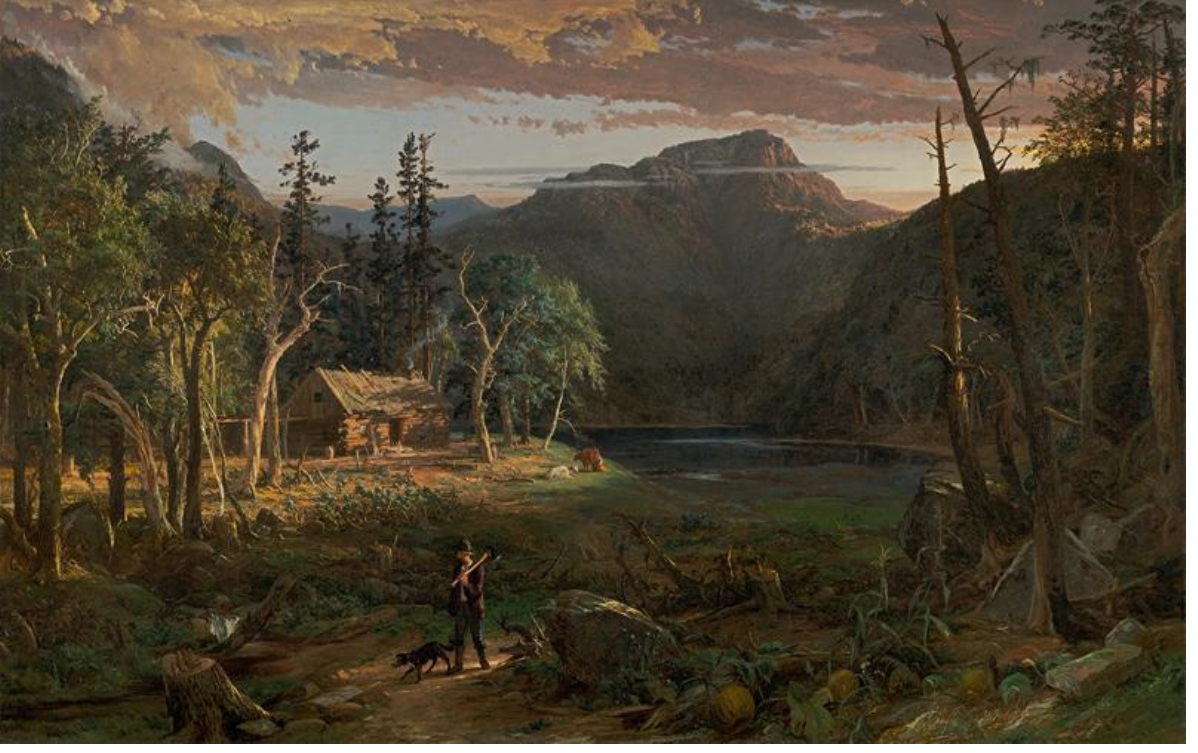
Figure 3. The Backwoods of America by Cropsey 1858. Oil on canvas. Crystal Bridges Museum of American Art.